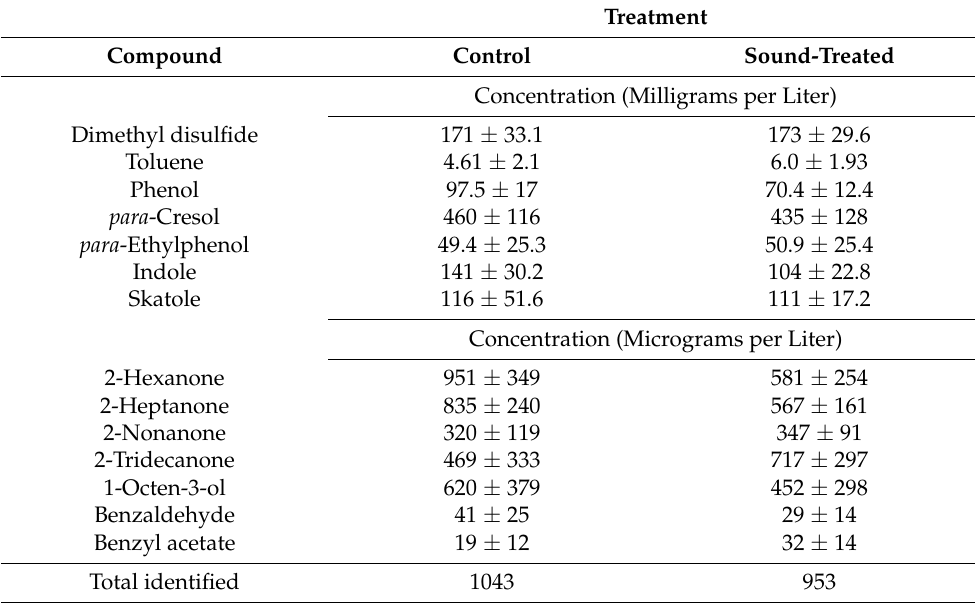
Table 2. Concentrations of malodorous compounds identified in anaerobic digestate 1